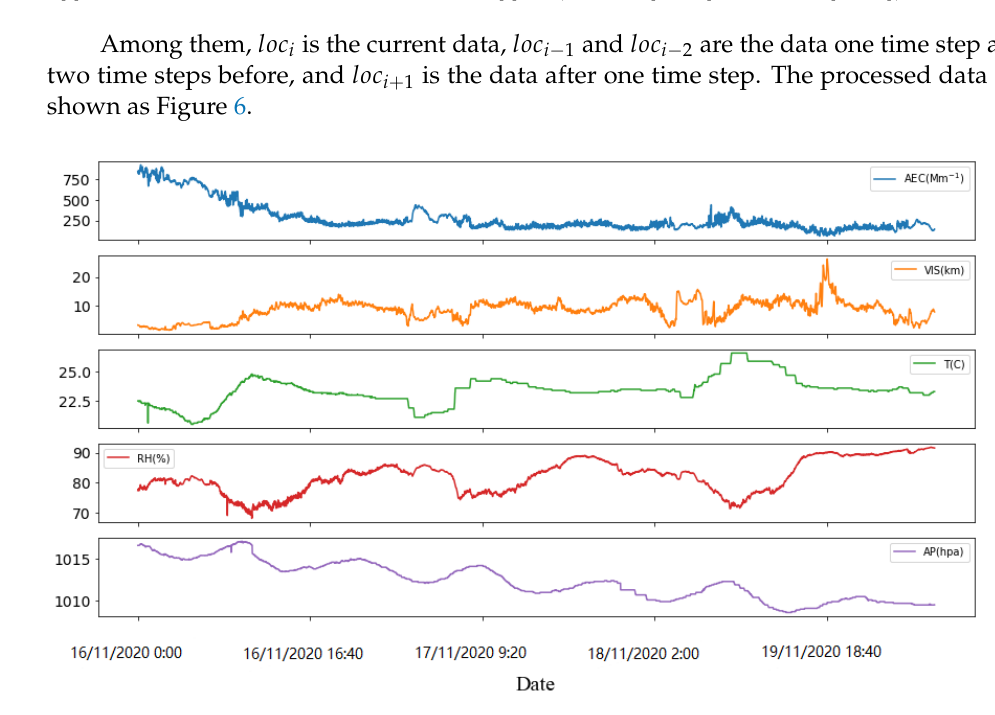
Figure 6. Coastal meteorological parameters of the Maoming area in November